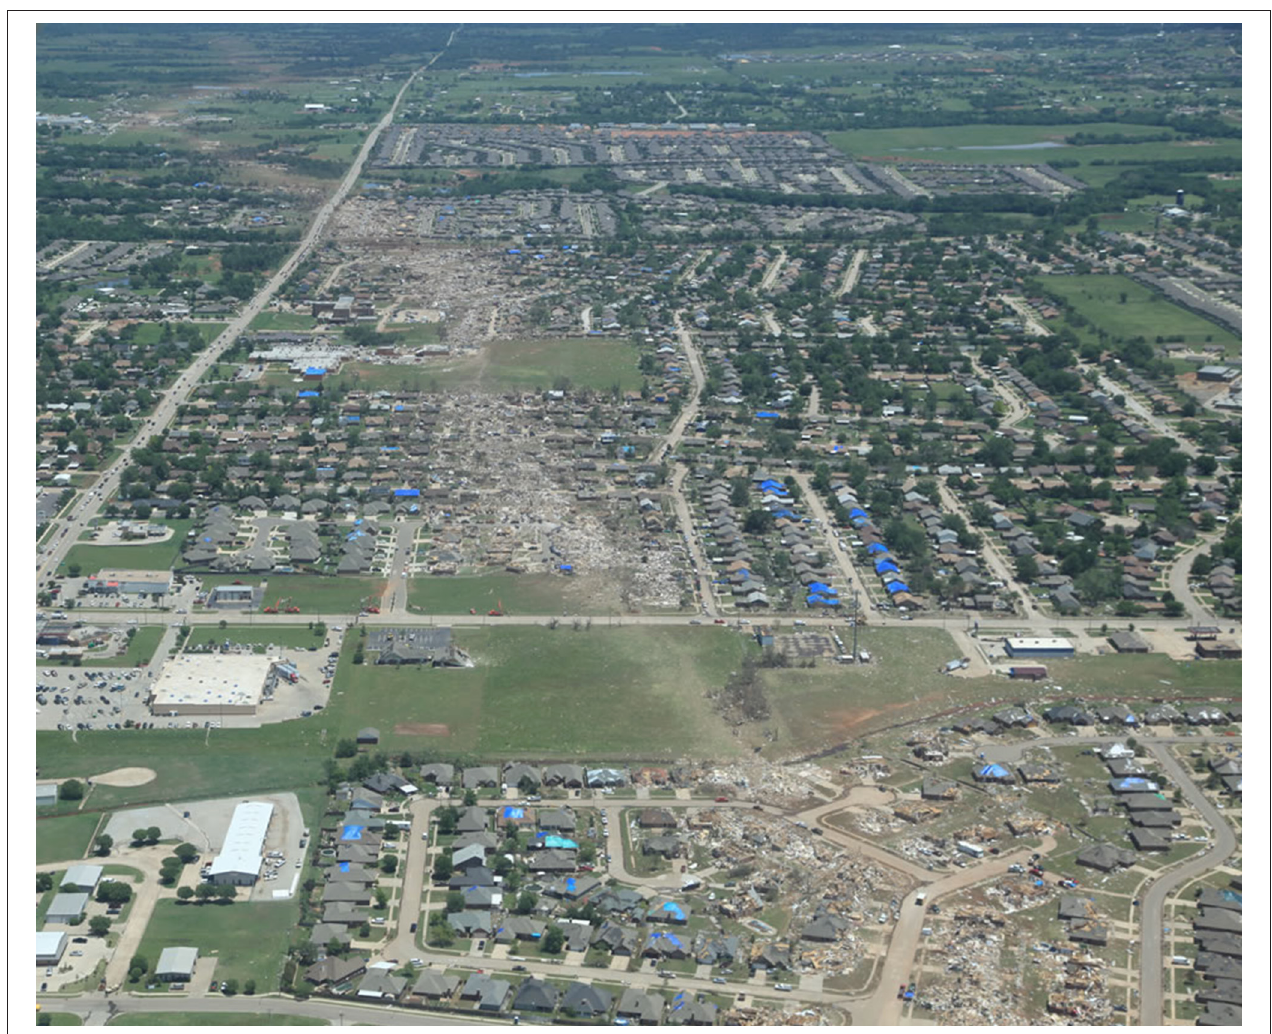
FIGURE 7 | Oblique photo from hand-held camera system in light aircraft clearly show the path of the 2013 EF5 tornado at Moore, OK. After: Dr. Nolan Atkins, Lyndon State University, NSF RAPID Response Grant AGS-1343963 (public domain: http://meteorology.lyndonstate.edu/vortex2/Moore2013/).